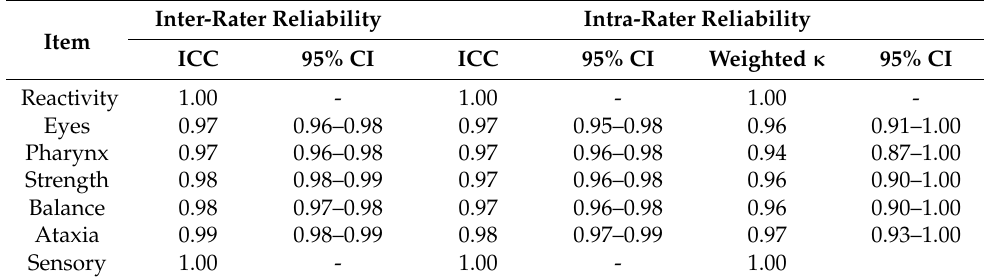
Table 4. Inter-rater and intra-rater reliability of Adam’s Scale of Posterior Stroke (ASPOS).